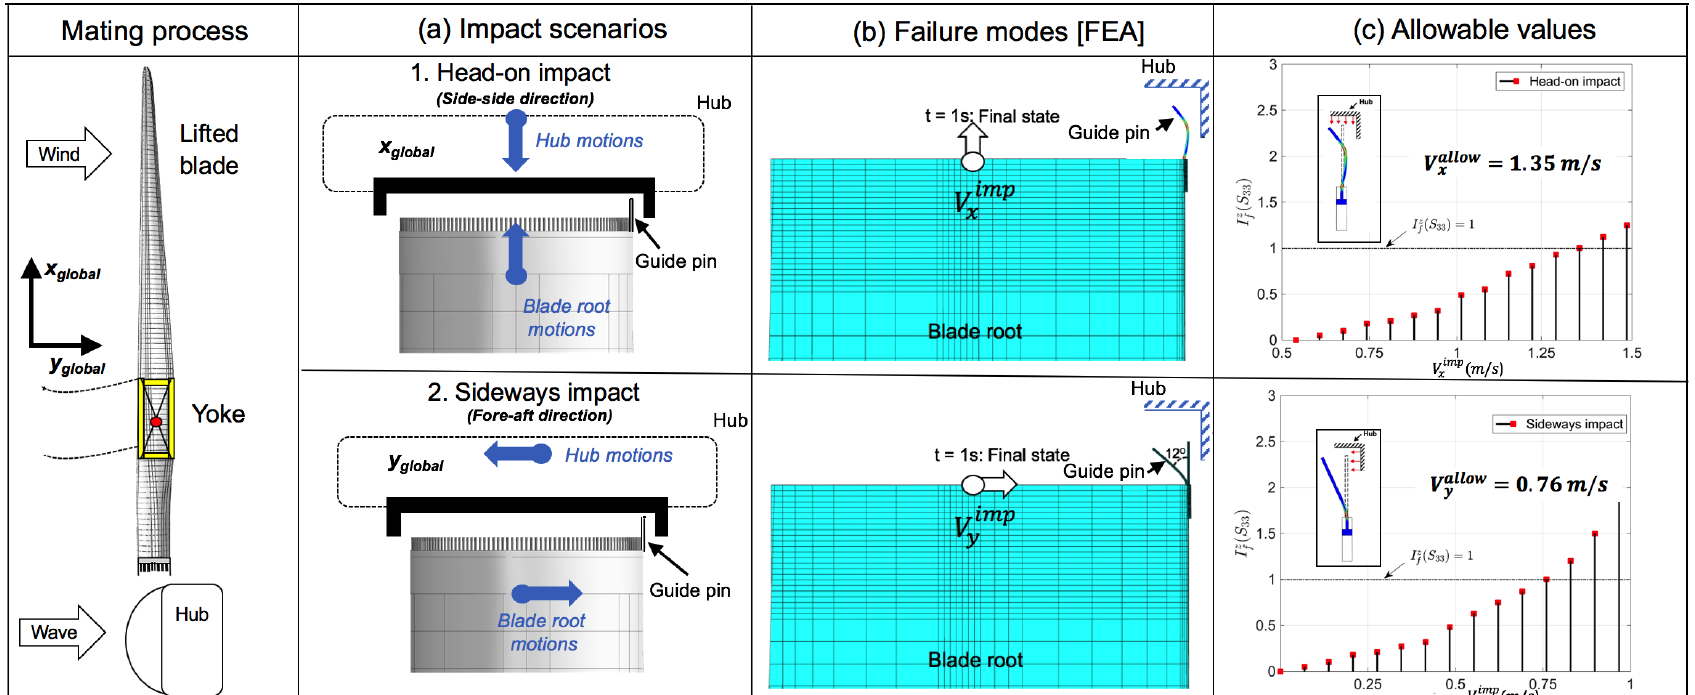
Figure 4. Critical event of blade-root impact with hub during mating: ( a ) impact scenarios, ( b ) failure modes at the blade root and ( c ) allowable impact velocities